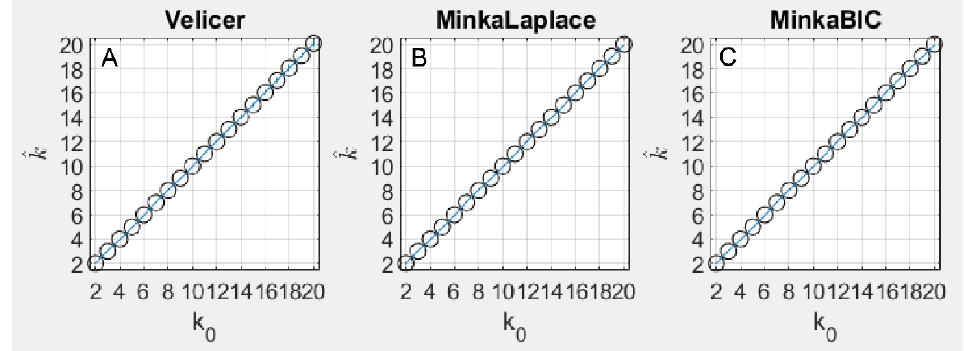
Figure 1. This figure plots the average accuracy result for the three methods based on PCA, including Velicer’s method ( A ), Minka Laplace method ( B ), and Minka’s BIC method ( C ). The results are plotted as the true number of components simulated on each x axis and the number of components discovered by each algorithm on each y axis. Perfect accuracy should appear as a diagonal line, and indeed that is nearly what each of these three methods achieved. Note that the standard deviation is shown for each estimate by blue error bars, although these errors are